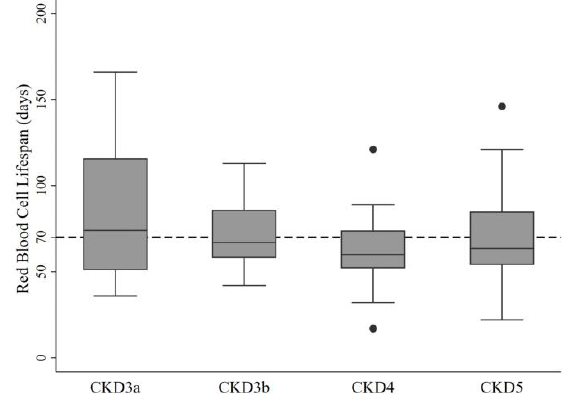
Figure 1. Distribution of RBCLS in patients with CKD stages 3–5.